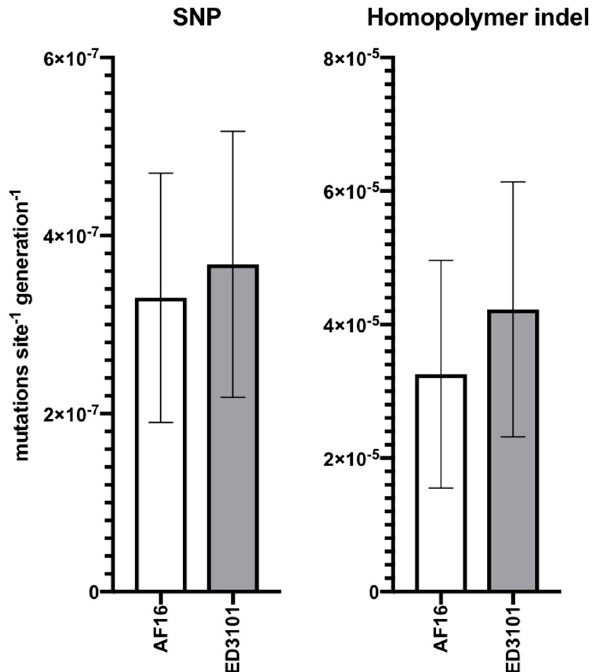
Figure 4. Mutation rate estimates for AF16 and ED3101 MA lines. For each isolate, mutation rates represent the combined estimate that includes their five respective MA lines. Homopolymer indel mutation rates were calculated based on only homopolymer indel variants that were found in runs ≥ 8 bp. Error bars are ± 1 standard error of the mean.